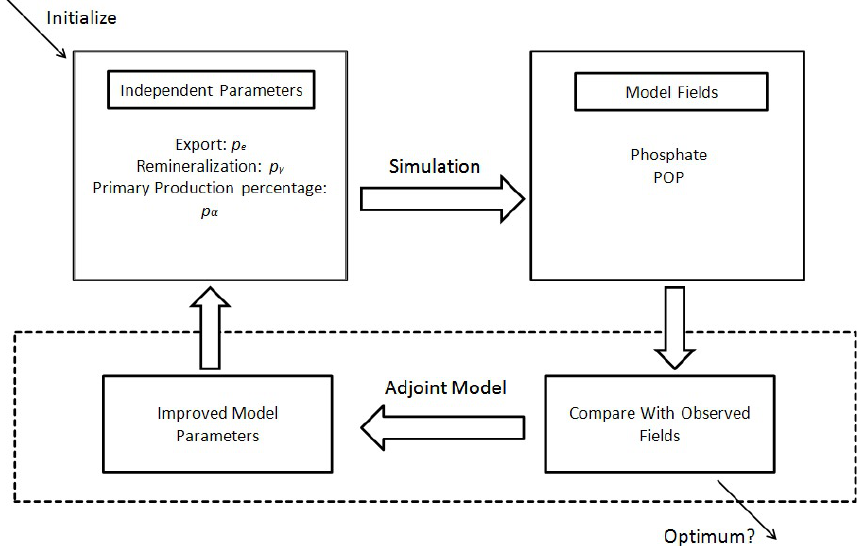
Fig. 5. Schematic overview of the model